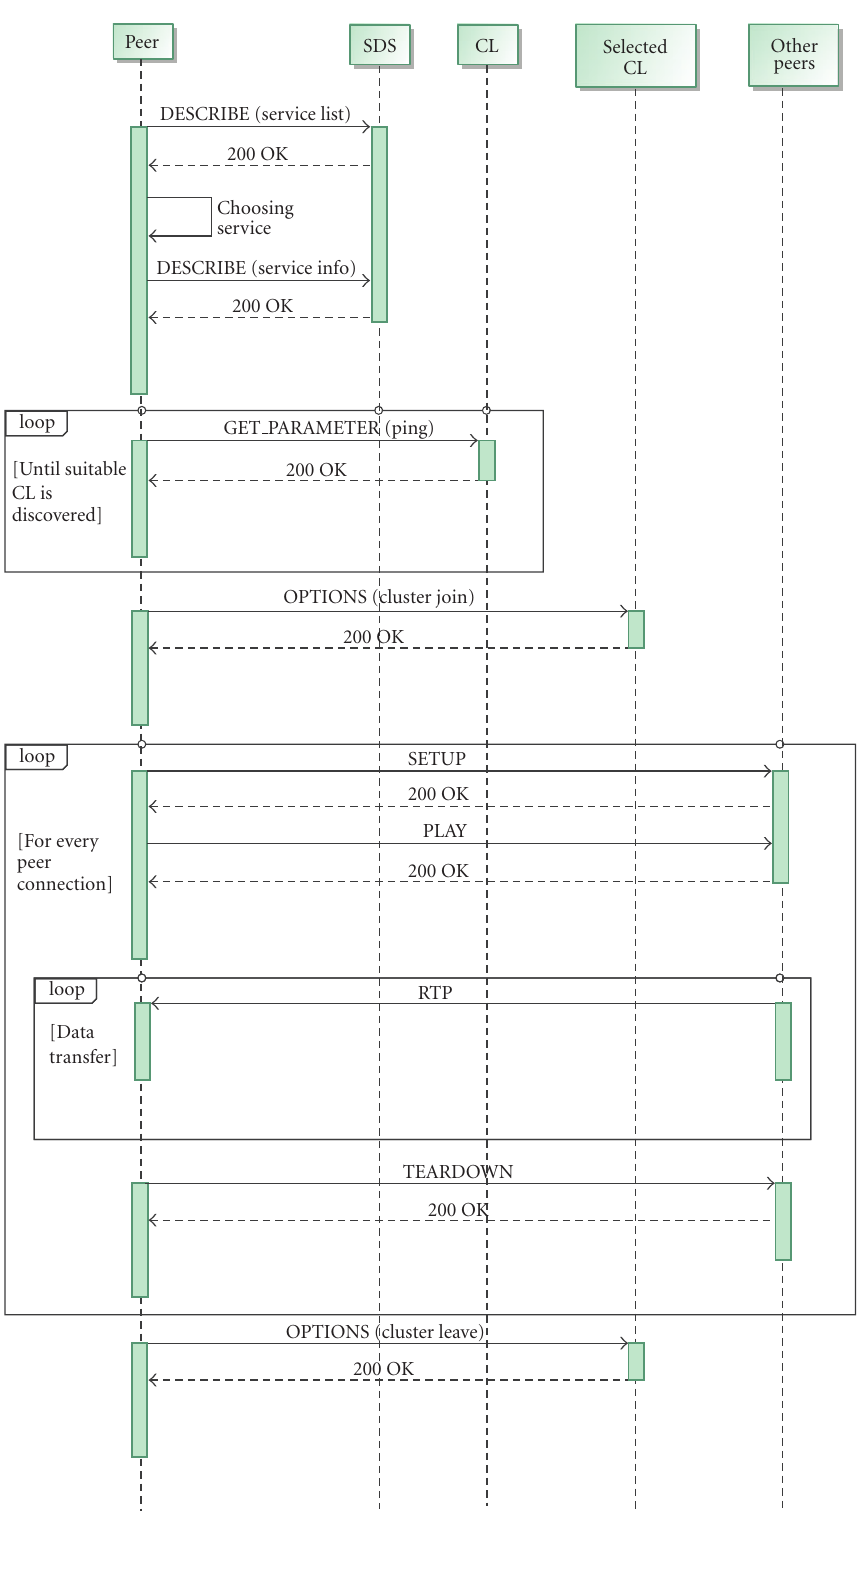
Figure 9: Peer in a